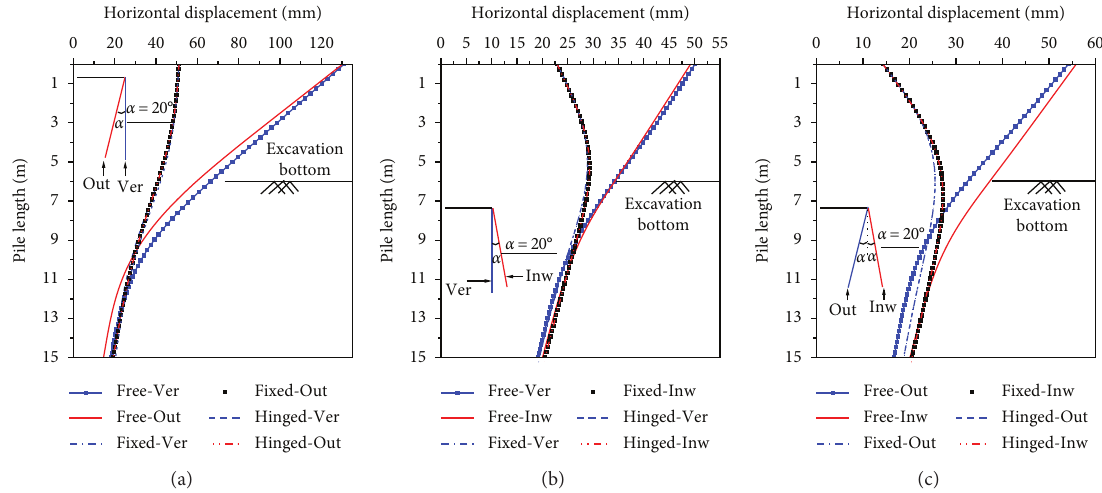
Figure 16: Comparison of horizontal displacements for different connection conditions at the pile top in CIRSs. (a) VOIP. (b) VIIP. (c) OIIP.